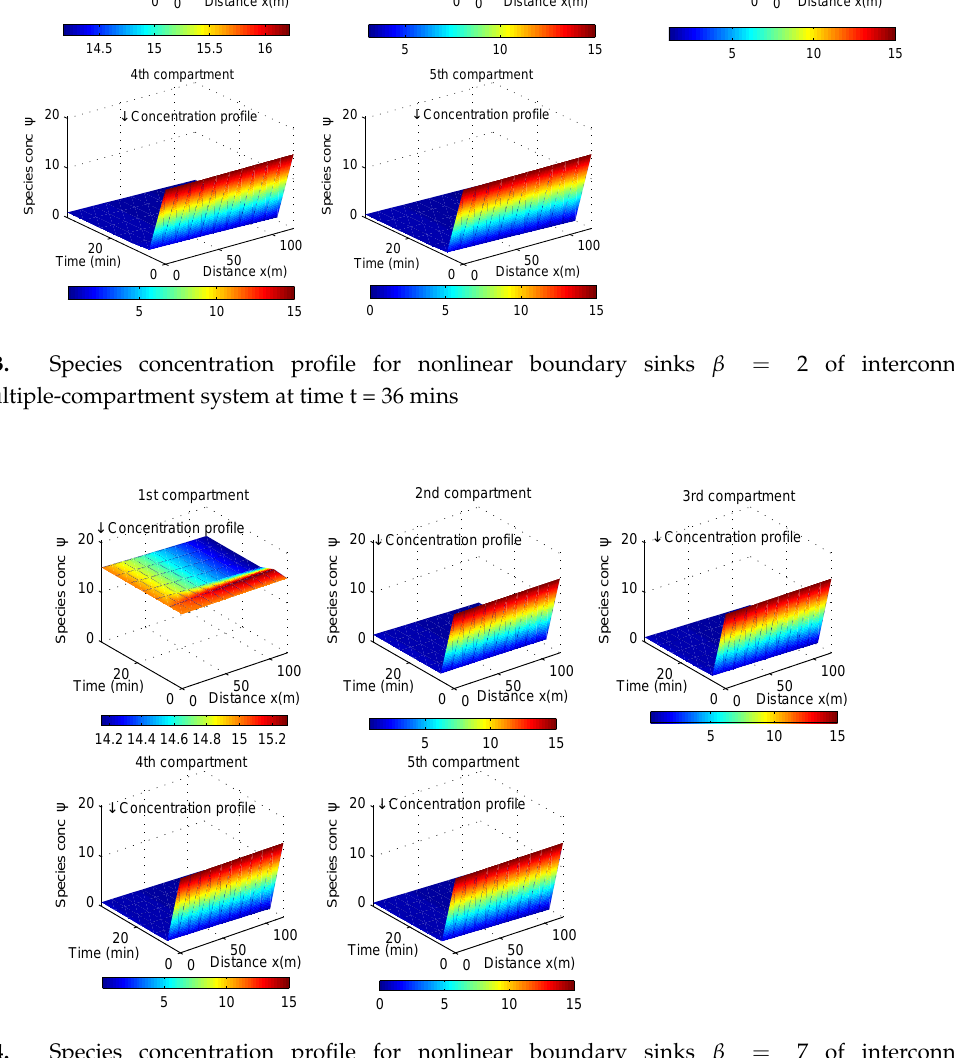
Figure 4. Species concentration profile for nonlinear boundary sinks β = 7 of interconnected (m=5)multiple-compartment system at time t = 36 mins From Figure 2 for linear boundary sink β = 1 at time t=36 minutes, end of one boundary and